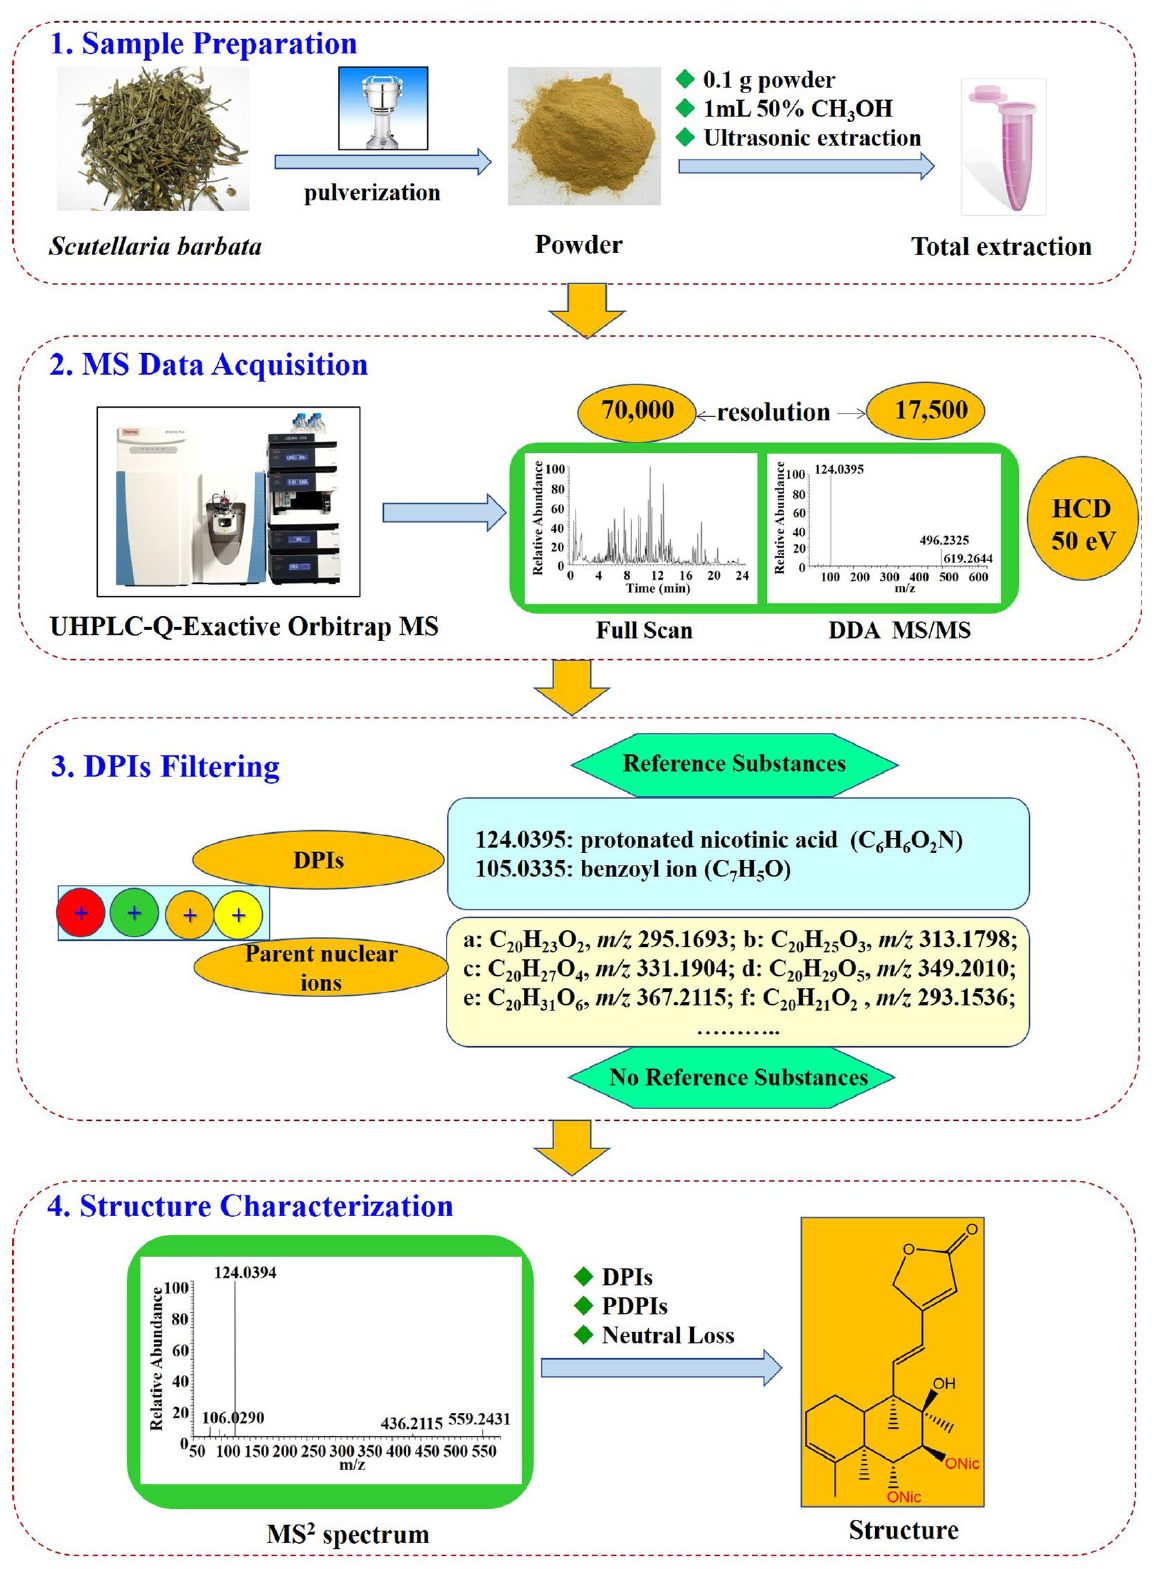
Figure 3. A flowchart for the stepwise DPIs filtering strategy developed for systematic exposure and characterization of diterpenoids in Scutellaria barbata .